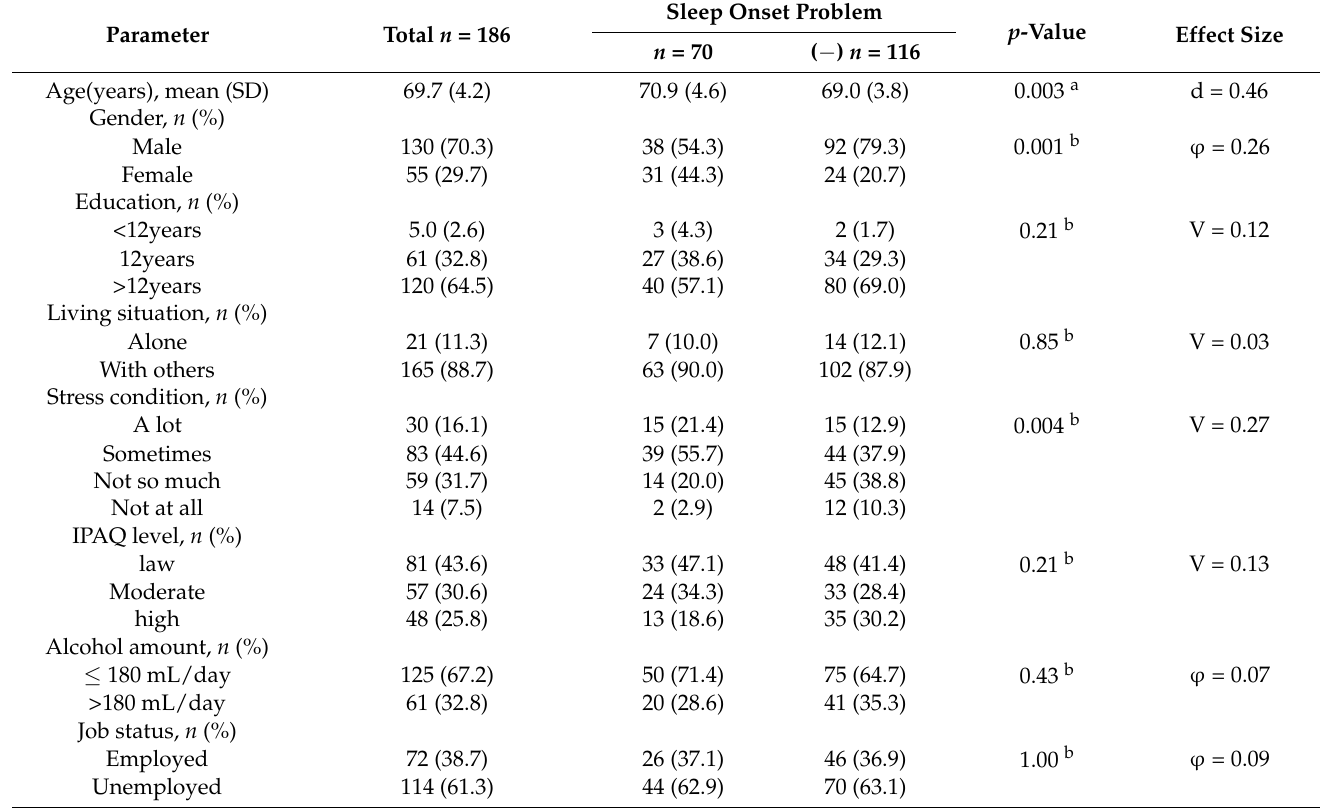
Table 1. Characteristics of